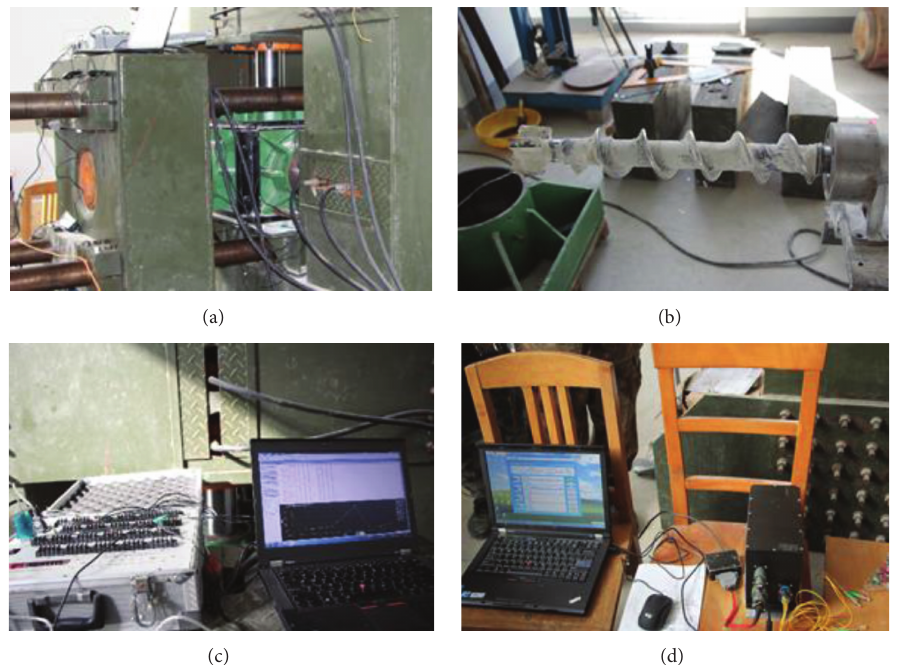
Figure 7: The process of test: (a) the process of loading; (b) the drill and excavation process; (c) internal pressure monitoring system; (d) FBG strain sensor monitoring system.